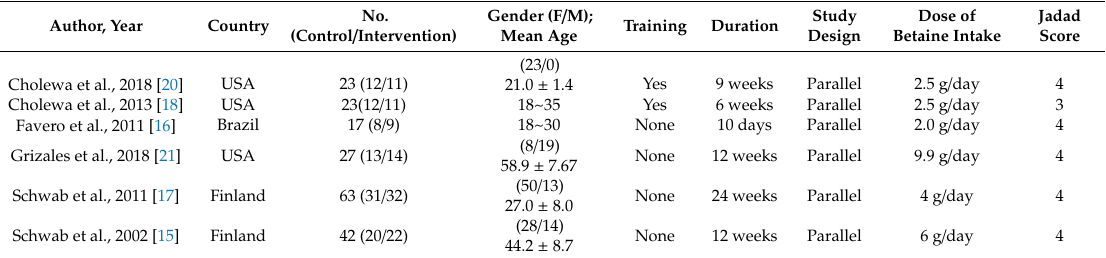
Table 1. Characteristics of the six eligible RCTs with betaine supplementation.